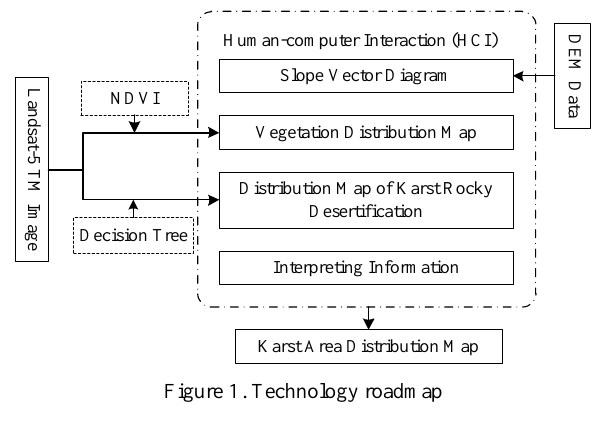
Figure 1. Technology